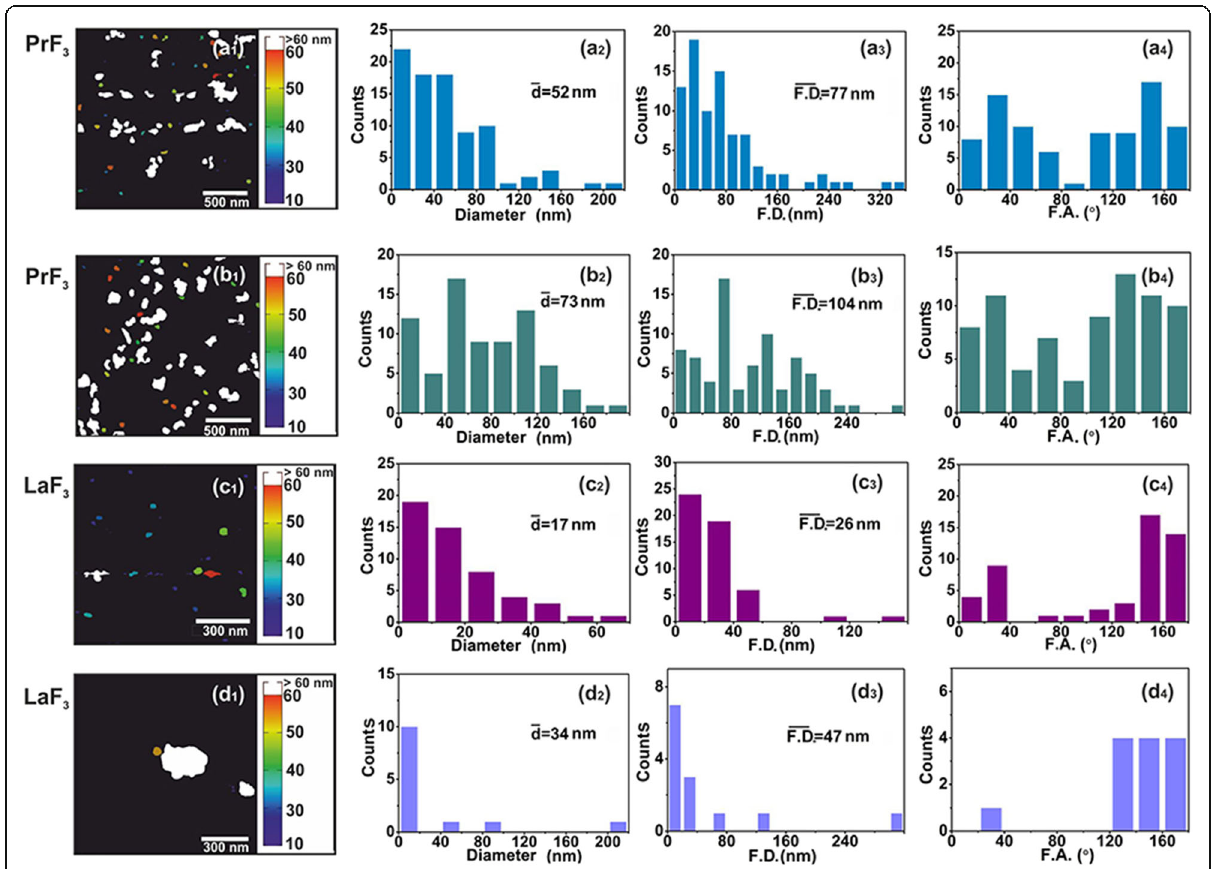
Fig. 2 AFM digital ( x , y ) size histograms of RE-NPs. ( a1 – d1 ) PrF 3 (2 × 2 μ m 2 ) and LaF 3 (1 × 1 μ m 2 ) NPs in DMEM+FBS suspensions. ( a2 – d2 ) ( x , y ) size histograms of mean equal circle area diameter ð d Þ of RE-NPs. (a3 – d3) ( x , y ) size histograms of Feret area diameters ð F : D : Þ of RE-NPs. ( a4 – d4 ) Feret angle (F.A.) histograms relative to the x -axis. RE-NPs were oriented along two main directions between ±(44 –